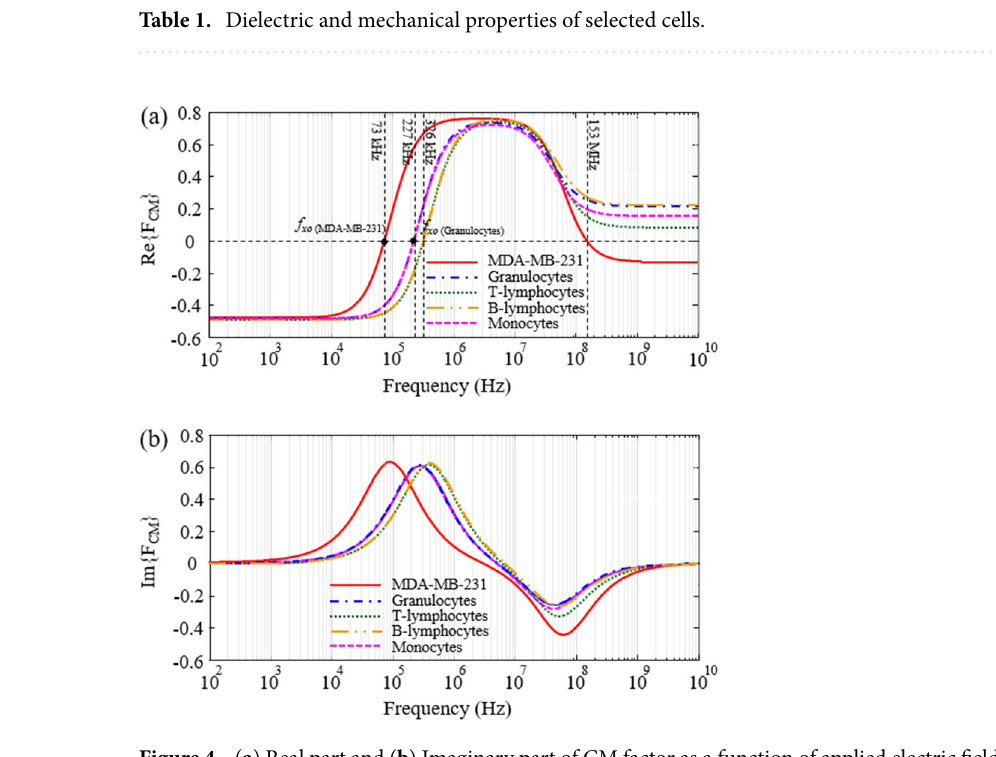
Figure 4. ( a ) Real part and ( b ) Imaginary part of CM factor as a function of applied electric field frequency for MDA-MB-231 and different subtypes of